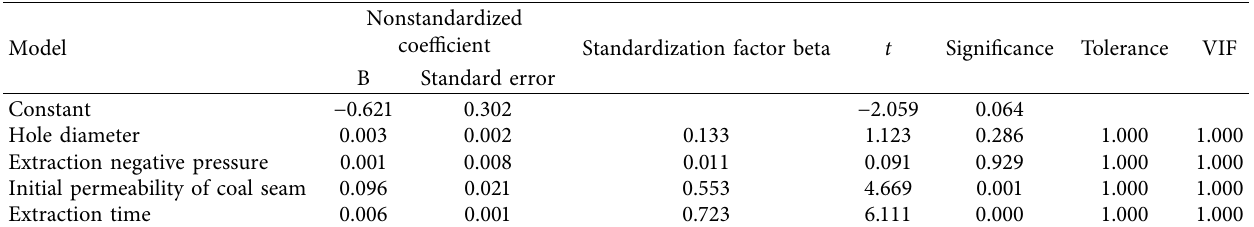
Table 8: Multiple regression coefficient